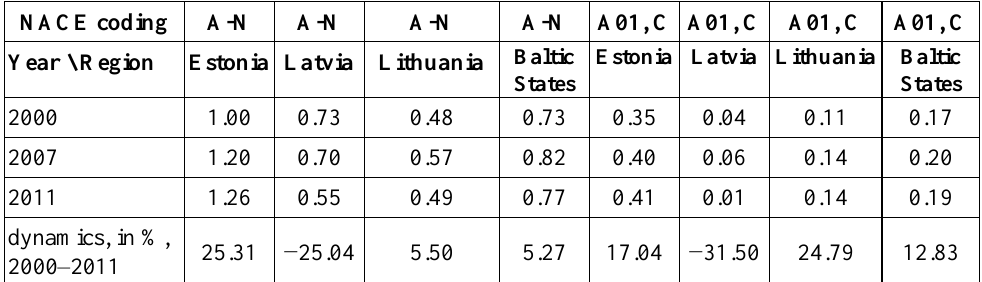
Table 4. Gini index calculation results: regional specialization of the analyzed commercial economy sectors in the Baltic States according to NACE rev.2 coding in 2000, 2007 and 2011, points [calculation and development made by authors] NACE coding A-N A-N